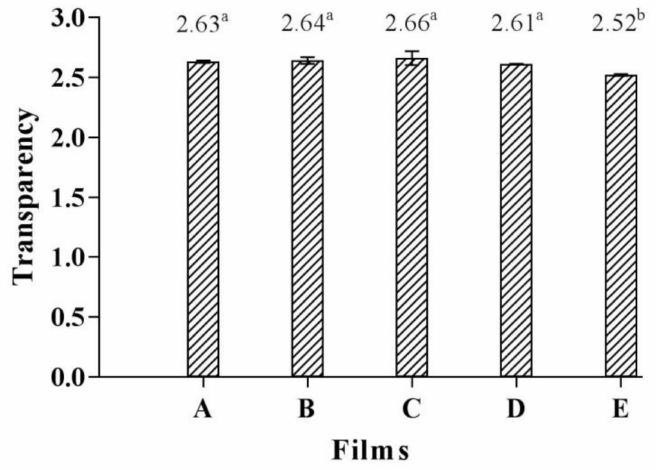
Figure 2. Transparency of ( A ) CMCy film, ( B ) CMCy75/RF25 composite film, ( C ) CMCy50/RF50 composite film, ( D ) CMCy25/RF75 composite film, and ( E ) RF film. Bars represent the standard deviation ( n = 3). Different letters indicate the significant difference ( p <